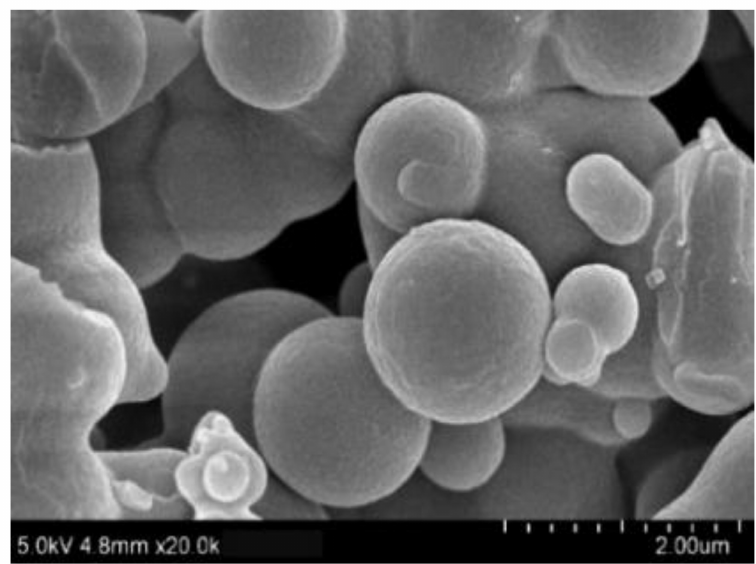
Figure 2. The SEM of water-insoluble gardenia blue pigment.